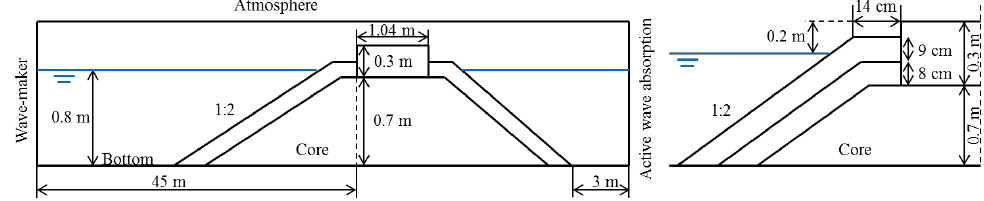
Figure 20. Sketch of the computational domain for the rubble mound breakwater case.